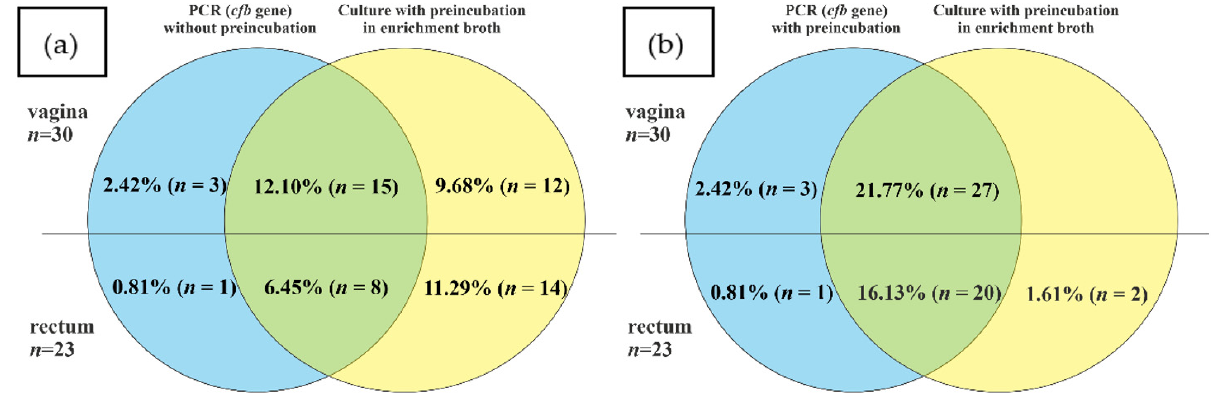
Figure 5. The comparison of GBS positive identification results by the culture method without preincubation in enrichment broth culture method and real-time PCR method for the cfb gene ( a , b ) preincubation in TH selective broth:. blue, percentage/number of positive samples only in real-time PCR; green, percentage/number of positive results both in culture method and real-time PCR (true positive), yellow, percentage of positive results in culture method only.